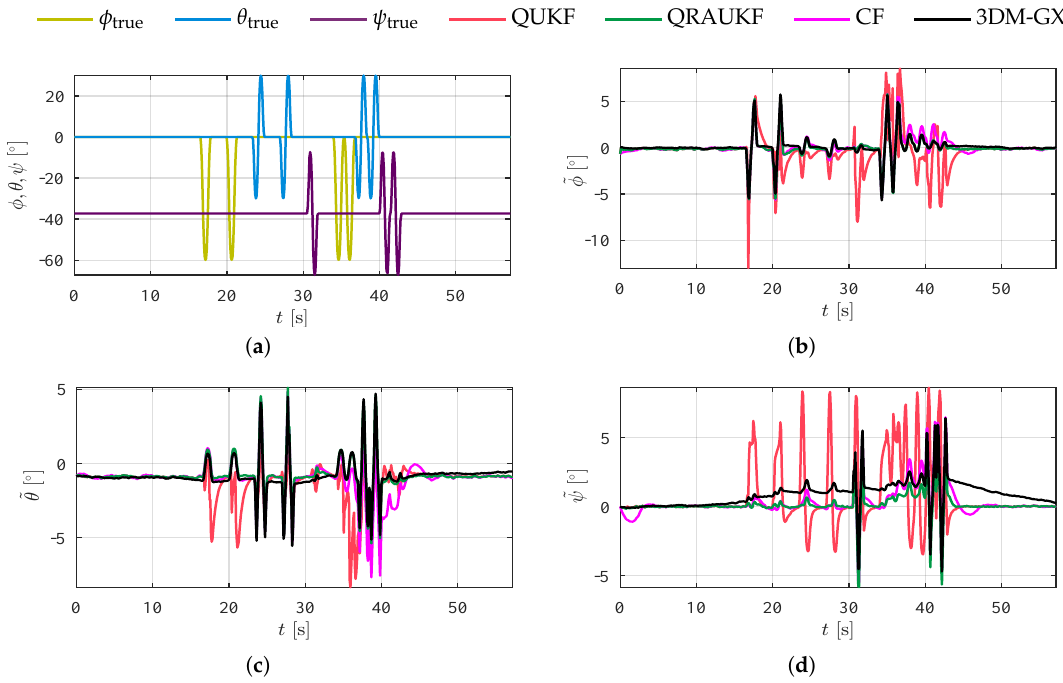
Figure 9. Results for individual axis rotation about the origin, scenario (iv). ( a ) shows actual orientation for individual axis movements; ( b – d ) show the estimation error for φ , θ and ψ angles,